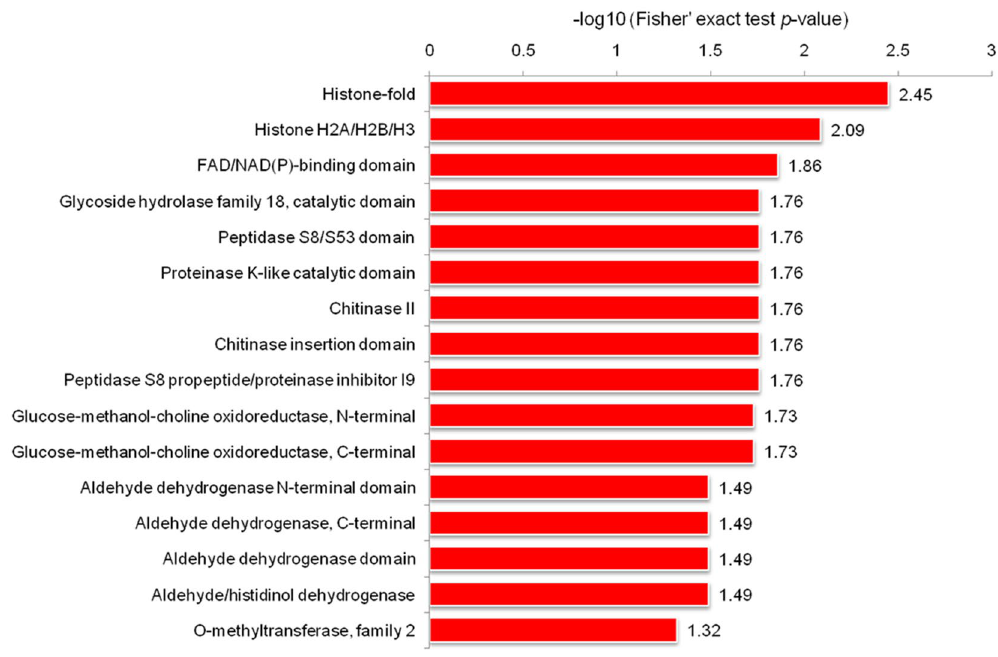
Figure 7. Domain-based enrichment analysis of all differentially regulated Kac proteins in C. chloroleuca 67–1.